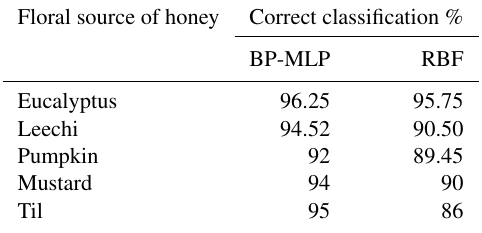
Table 3. Classification results using the BP-MLP and RBF network